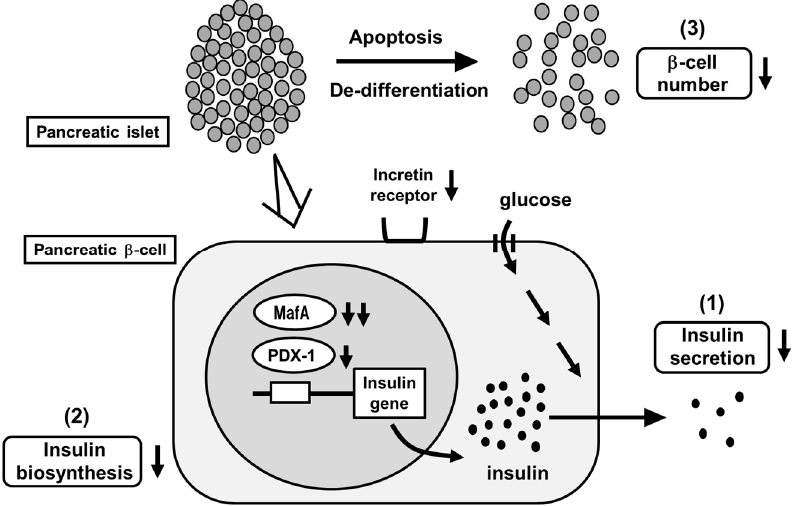
Figure 1. Pancreatic β -cell glucose toxicity found in type 2 diabetes mellitus (T2DM). When pancreatic β -cells are exposed to chronic hyperglycemia, β -cell function gradually declines. First, insulin secretion is reduced. Second, insulin biosynthesis is reduced together with reduction of MafA and PDX-1 expression. Third, β -cell number is decreased through the process of apoptosis and/or de-differentiation.